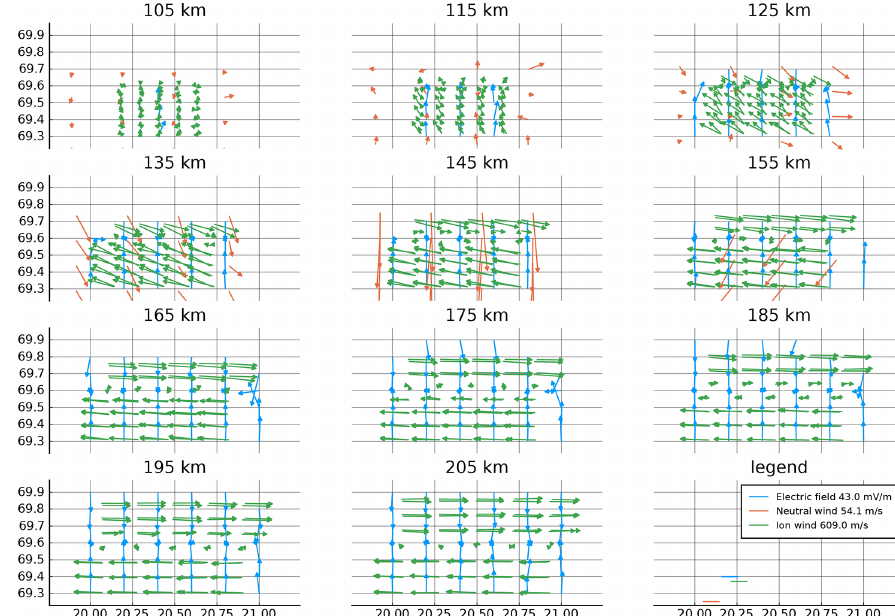
Figure 11. Estimated neutral wind (blue) and electric field (red) together with ion wind measurements (green). The plots for the uppermost and lowermost ranges look similar to their neighboring range and are not plotted. Electric field vectors where at least one component has an uncertainty larger than 10mVm − 1 are not shown. Likewise, neutral wind vectors are not shown if one component has an uncertainty larger than 30ms − 1